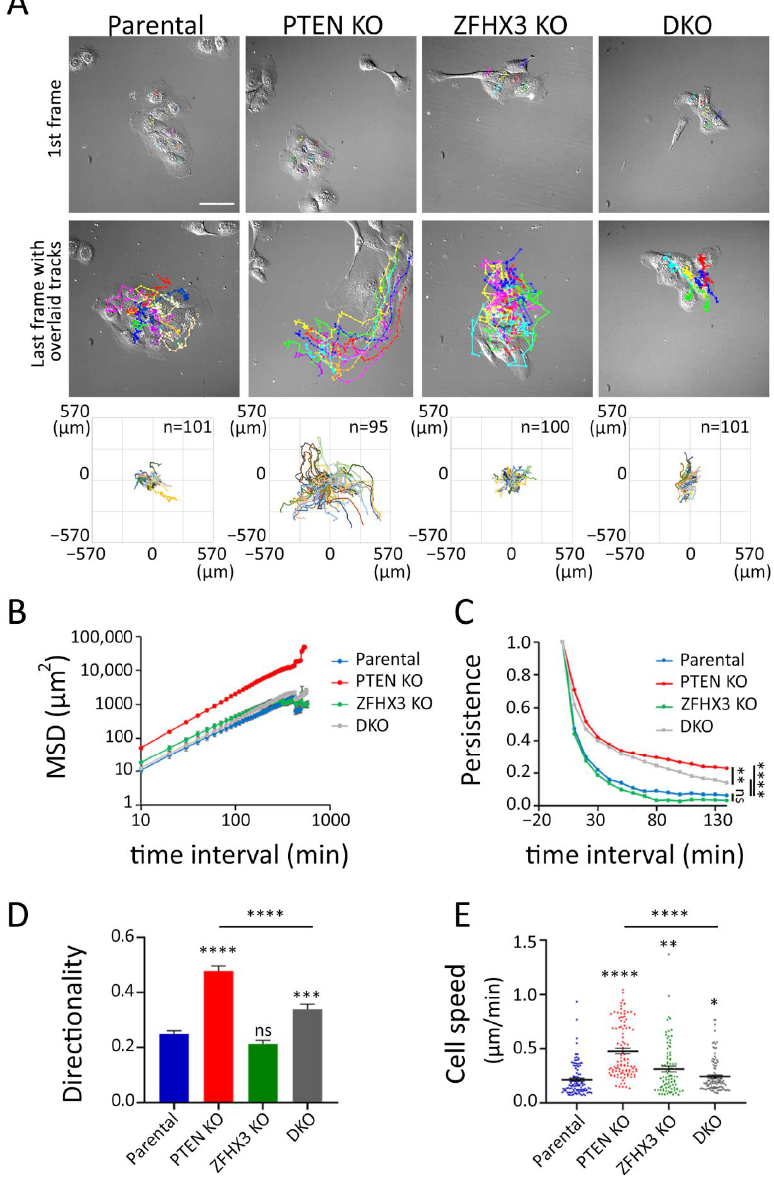
Figure 3. Collective migration of gene-edited MCF10A cell lines in sparse culture. ( A ) First frames of video and last frames with cell trajectories. Scale bar: 100 µ m. ( B – E ) Plots characterized the migration behavior of gene-edited MCF10A cells: ( B ) A log-log plot of mean square displacements (MSD); ( C ) migration persistence; ( D ) directionality ratio over elapsed time (16 h); ( E ) mean cell speed. Data from 3 independent experiments; more than 100 cells for each line were monitored. Mean ± SEM. Kruskal – Wallis test, * p < 0.05, ** p < 0.01, *** p < 0.001, **** p < 0.0001 and ns: non-significant.